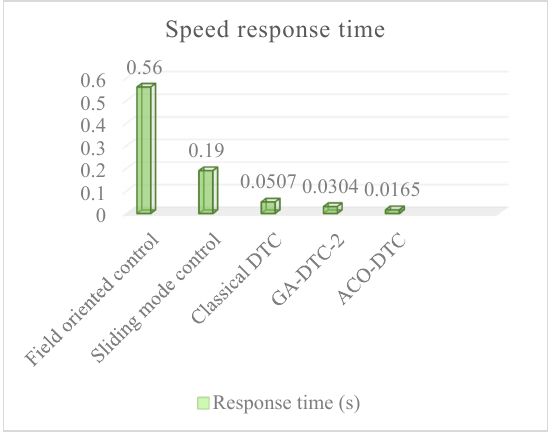
Figure 19. Various speeds response time of several approaches for DFIM.